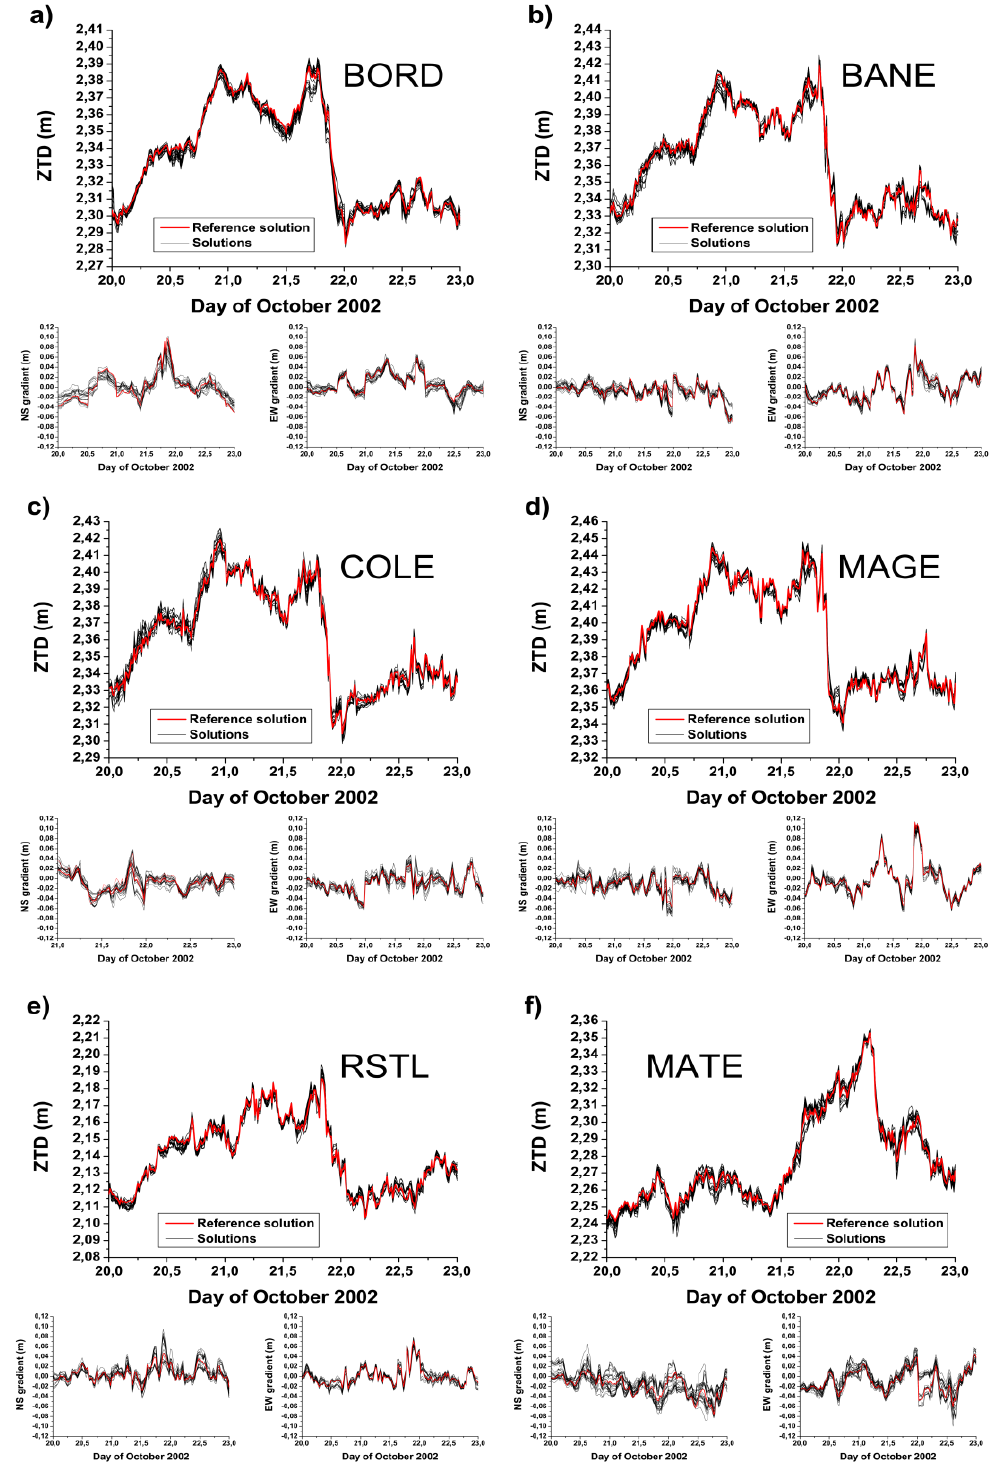
Figure 3: ZTDs and horizontal gradients (NS and EW components) from different geometric network configurations for 6 stations: (a–d) 4 local stations (BORD, BANE, COLE and MAGE), (e) RSTL (Rustrel) a permanent station from the French RENAG network, (f) MATE (Matera, Italy) a EUREF reference stations. Thirty-six solutions are shown over the interval covering 20–22 October 2002 (day of year 293–295). All solutions apply standard constraints on tropospheric parameter variability and are established in a free reference frame.